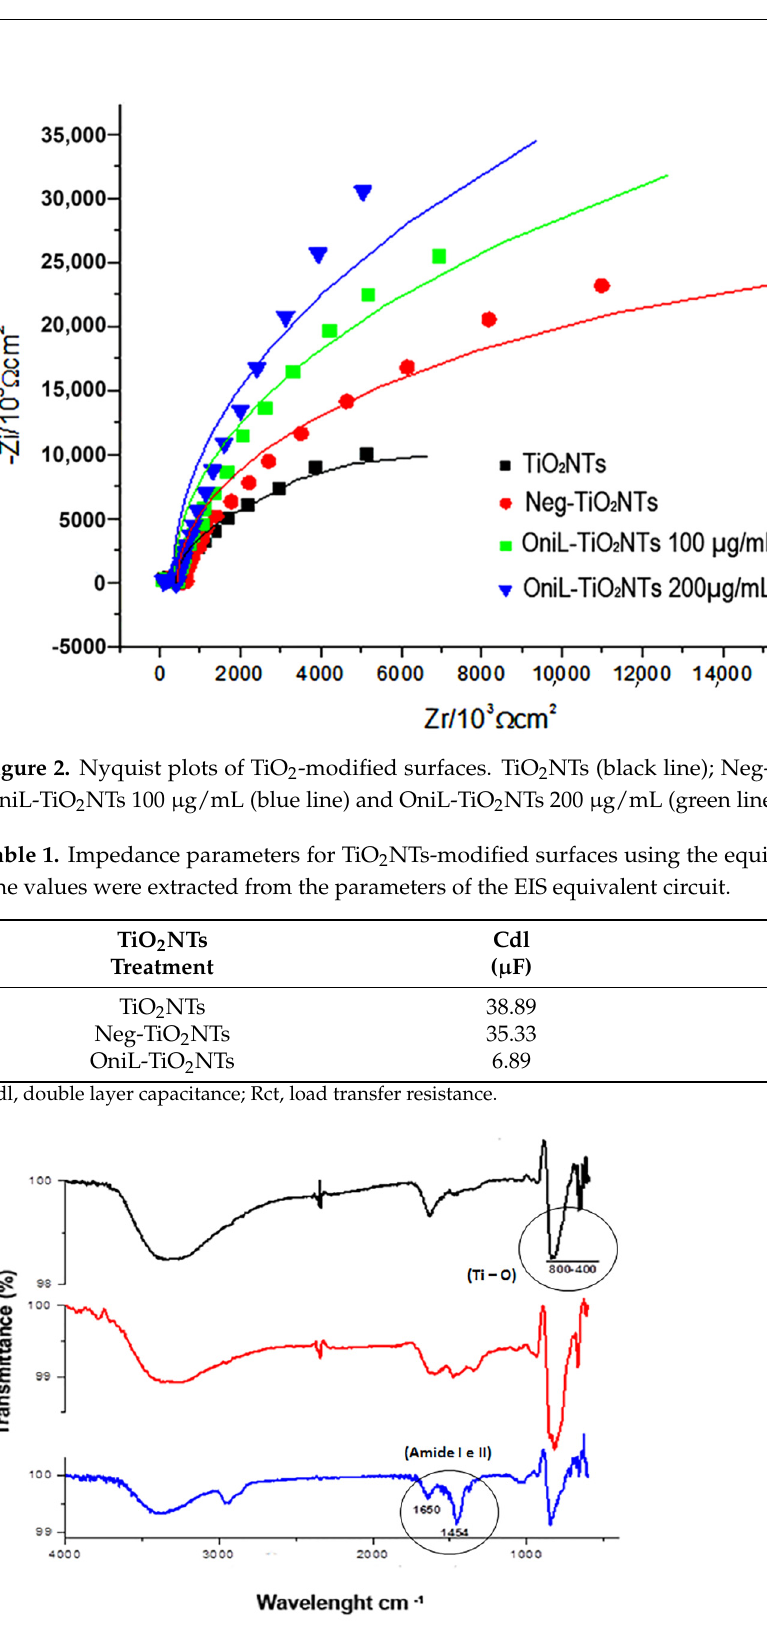
Figure 3. FTIR analysis of TiO 2 -modified surfaces. General aspect of the FTIR spectra of bare TiO 2 NTs (black line), Neg-TiO 2 NTs (red line), and NegOniL-TiO 2 NTs (blue line).